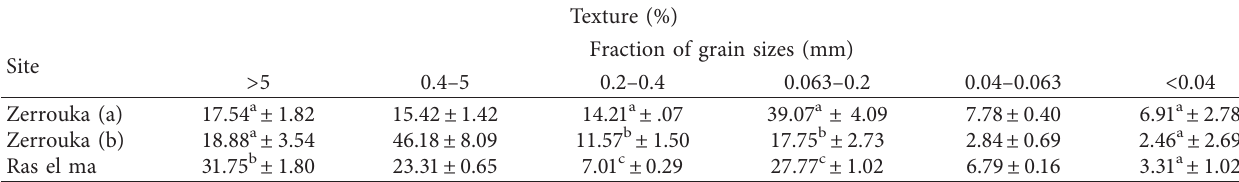
Table 3: Particle size characteristics of soils.